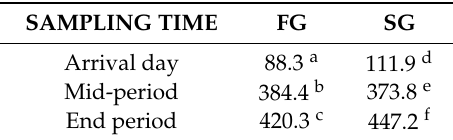
FG: Fast-growing breed. SG: Slow-growing breed. a,b,c : Di ff erent superscripts within column FG indicate a significant di ff erence within group ( p ≤ 0.05). d,e,f : Di ff erent superscripts within column SG indicate a significant di ff erence within group ( p ≤